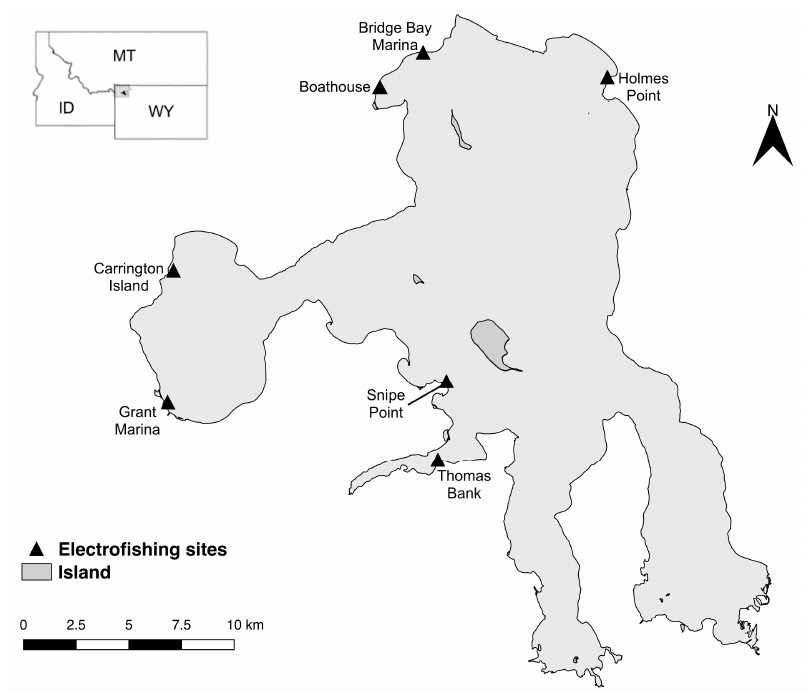
Figure 1. Map of Yellowstone Lake, Wyoming with 2020 electrofishing sites.